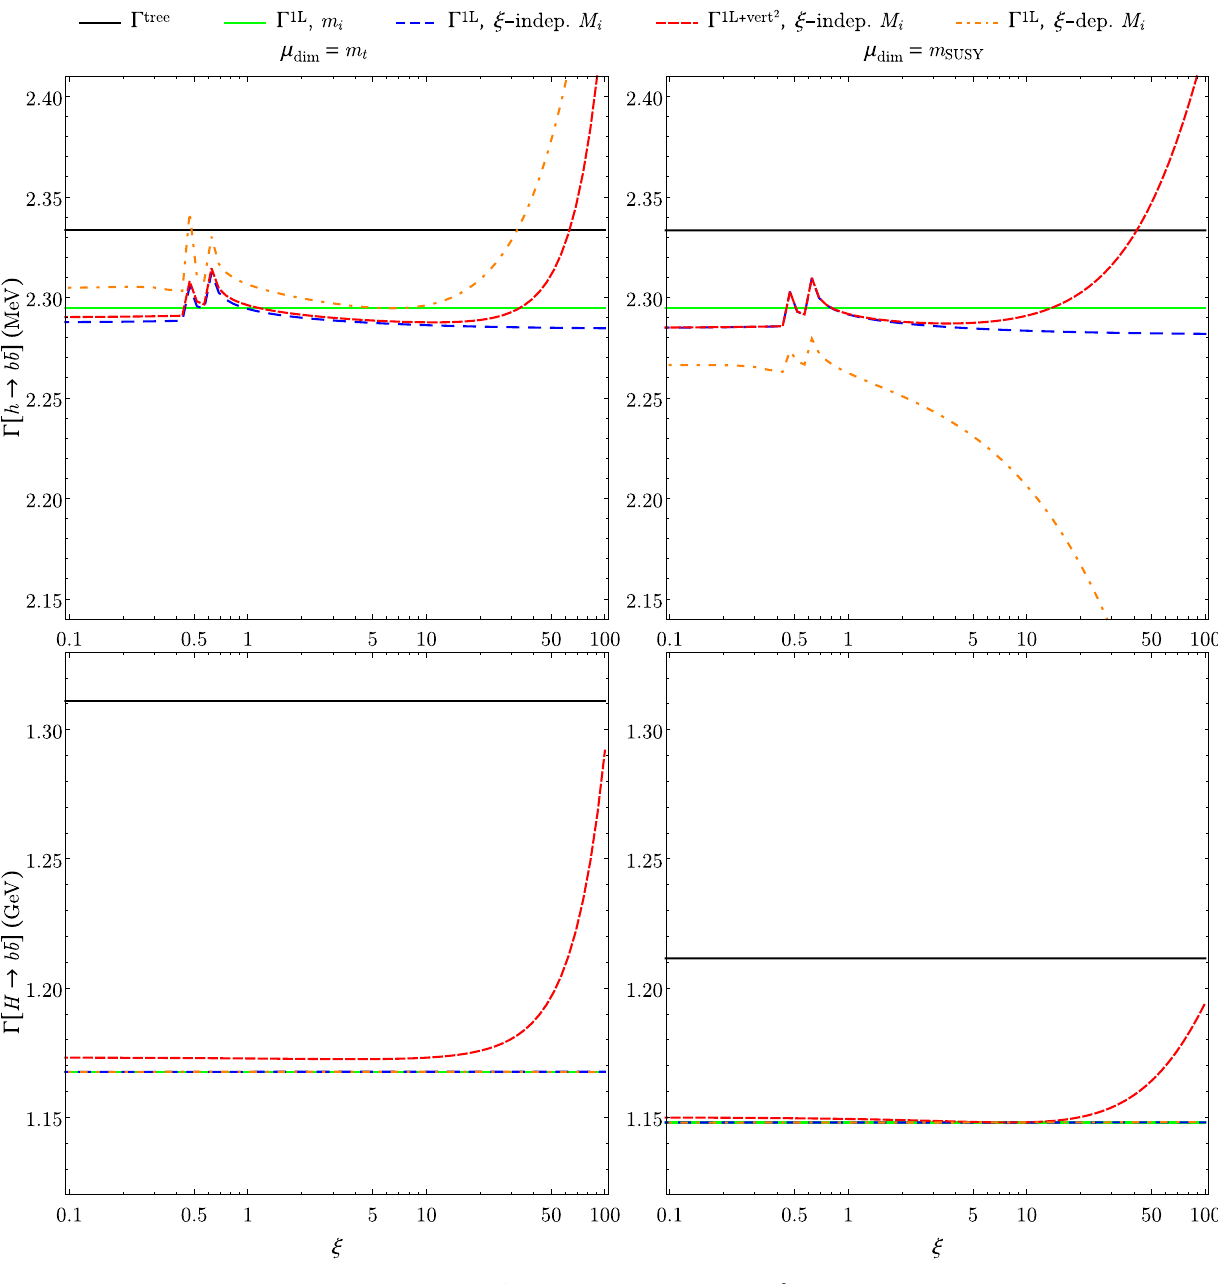
addition, a | A vert | 2 piece is kept in the squared amplitude for the dashed red curve. In the dot-dashed orange curve, no explicit contribution to the decay of two-loop order is included, but the momentum is set to the ξ -dependent Higgs mass of Eq.(5). The renormalization scale is set to m t on the left-hand side, and to m SUSY on the right-hand side. The decay widths for the pseudoscalar state have been omitted since they are essentially identical to those of the heavy CP -even state (lower row)